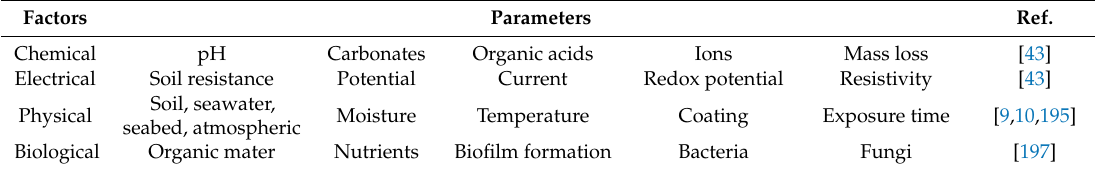
Table 1. Main external environments a ff ecting operating pipelines to develop SCC.